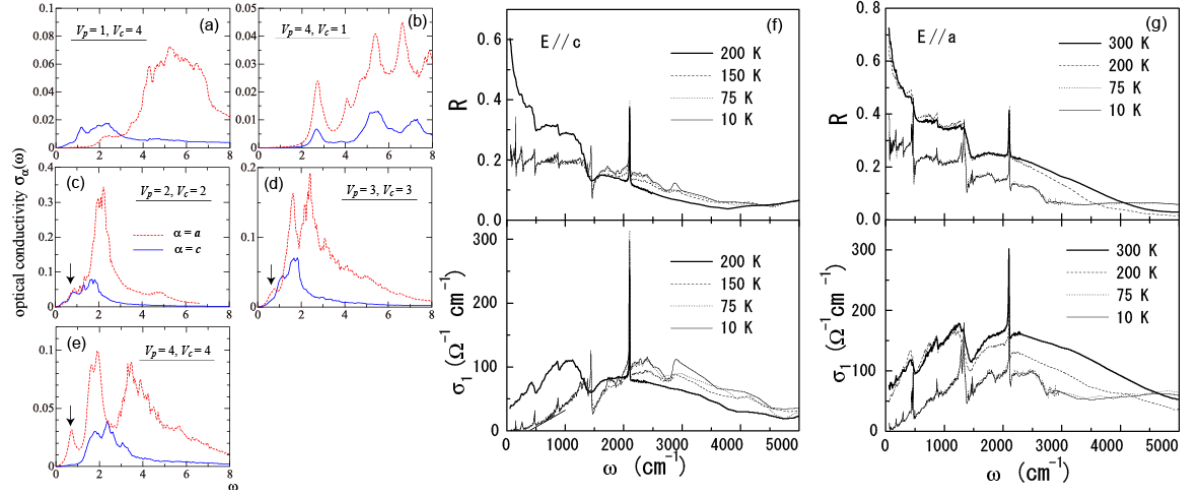
Figure 13. Reflectivity and optical conductivity of θ -(BEDT-TTF) theoretical calculation of the optical conductivity of a triangular lattice. The arrows in ( c ), ( d ), and ( e ) denote the Drude peaks, which appear at finite energy because the open-end boundary condition is applied for a finite size cluster of L are taken from ref. [96], and Figure 13f,g are taken from ref.